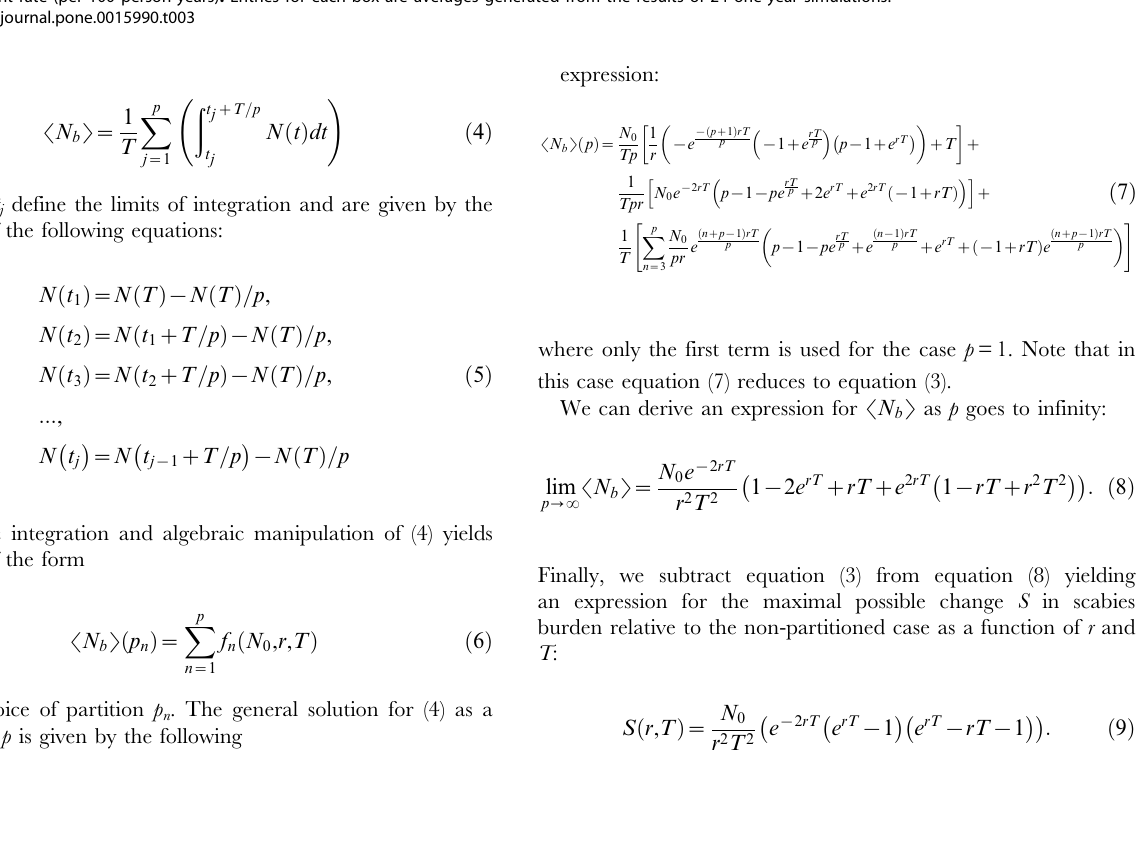
Scenario 2 Q =5 6 10 2